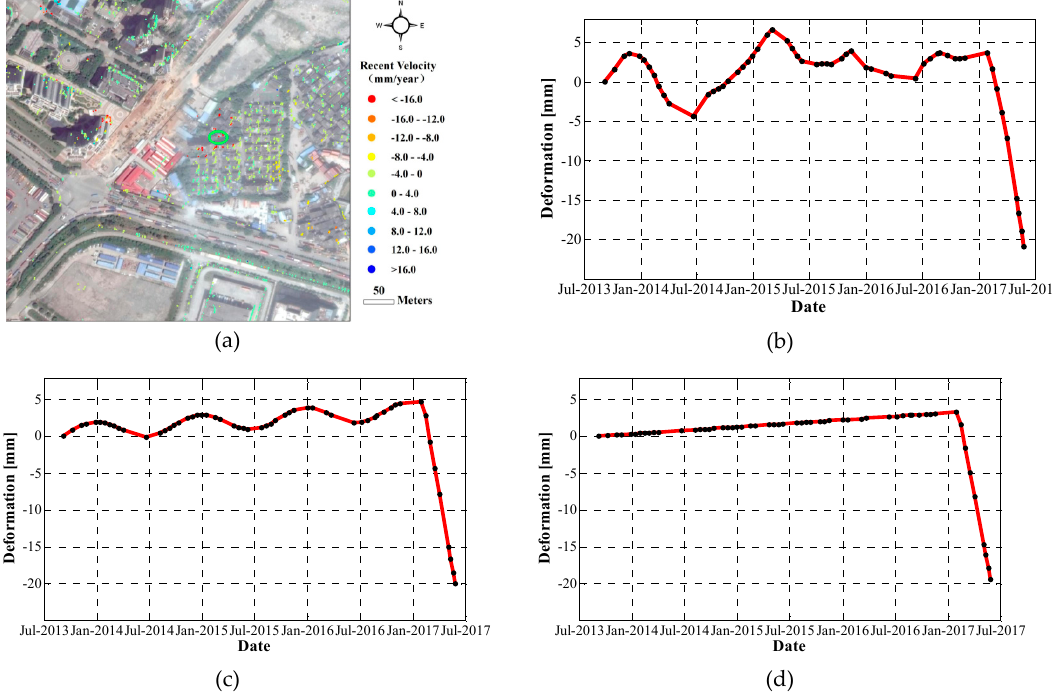
Figure 11. ( a ) PS recent velocity measurements in area B of Figure 9b; ( b ) measured deformation evolution of the PS circled in green in ( a ); ( c ) sum of periodic and piecewise linear components of the PS displacement; ( d ) piecewise linear component of the PS